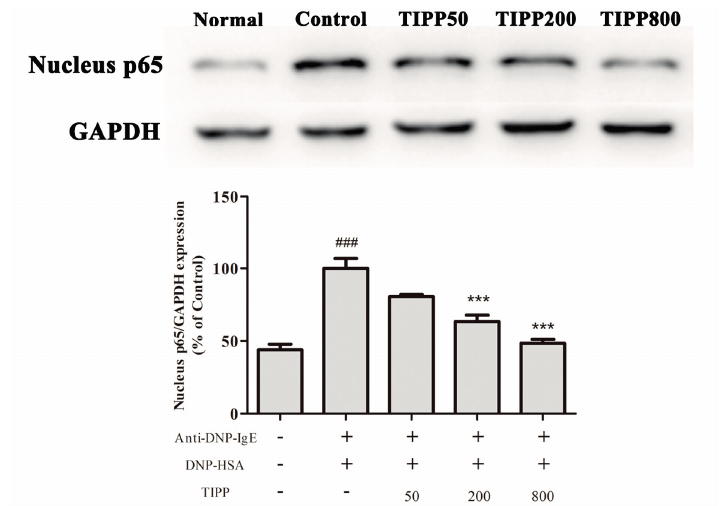
Figure 9. Effect of TIPP on the nuclear translocation of NF- κ B. The Western blot diagram is a representative of three independent experiment diagrams with similar results. Each lane was loaded with 20 μ g of total protein. Results are expressed as mean ± SEM ( n = 3). Compared with Normal group, ### p < 0.001; compared with Control group, *** p <